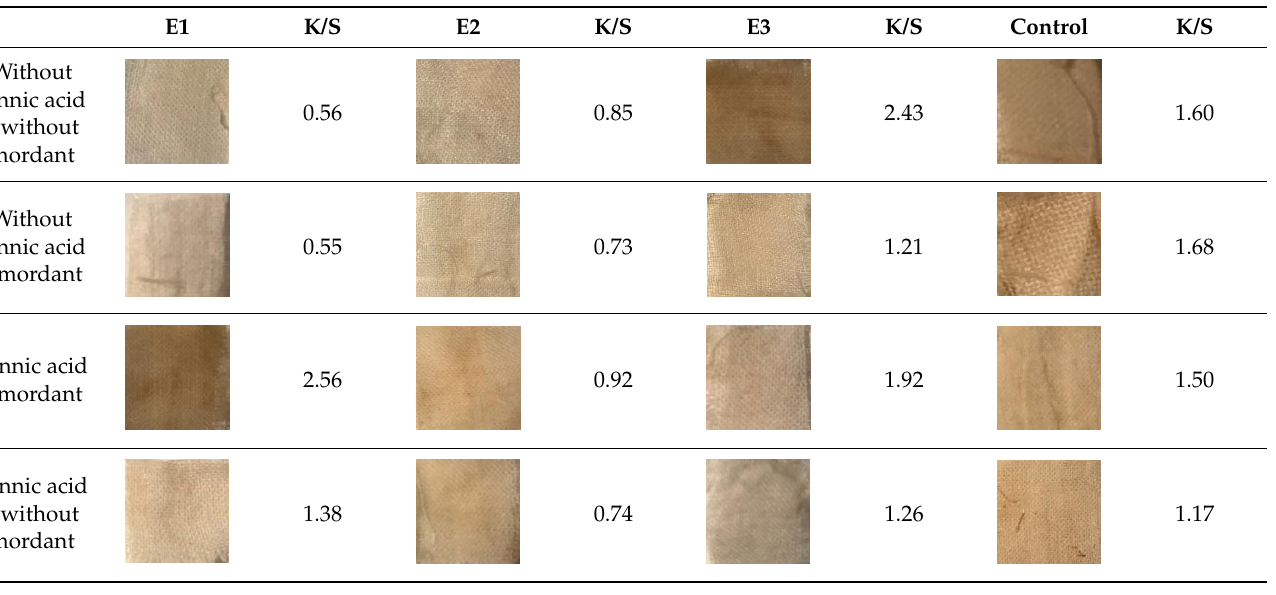
Table 7. Images and K/S of fabrics dyed with cork extracts obtained by extraction with the three extracts, E1 (extracted with NADES 1), E2 (extracted with NADES 2), and E3 (extracted with NADES 3), and with water (control), using four different pre-treatment methods (with and without tannic acid and with and without mordant).